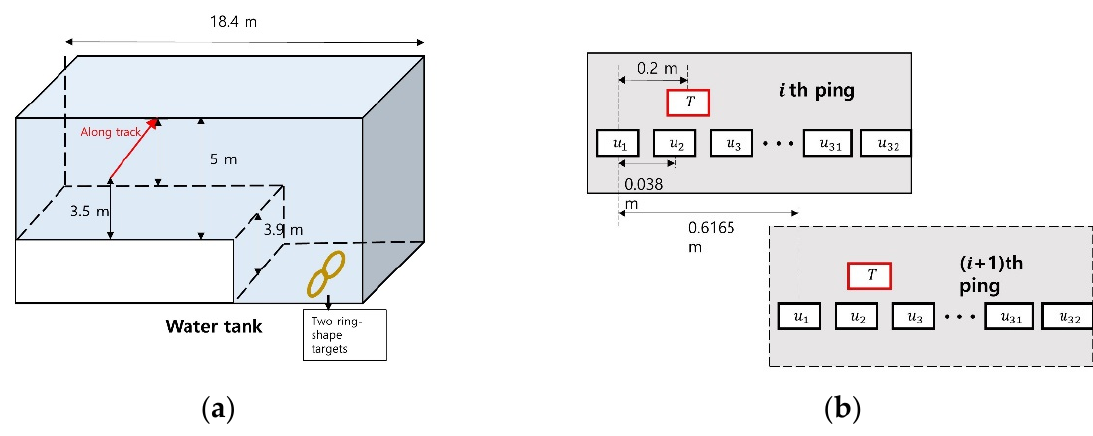
Figure 13. Water tank experiment overview: ( a ) water tank structure; ( b ) synthetic aperture line-array sonar.